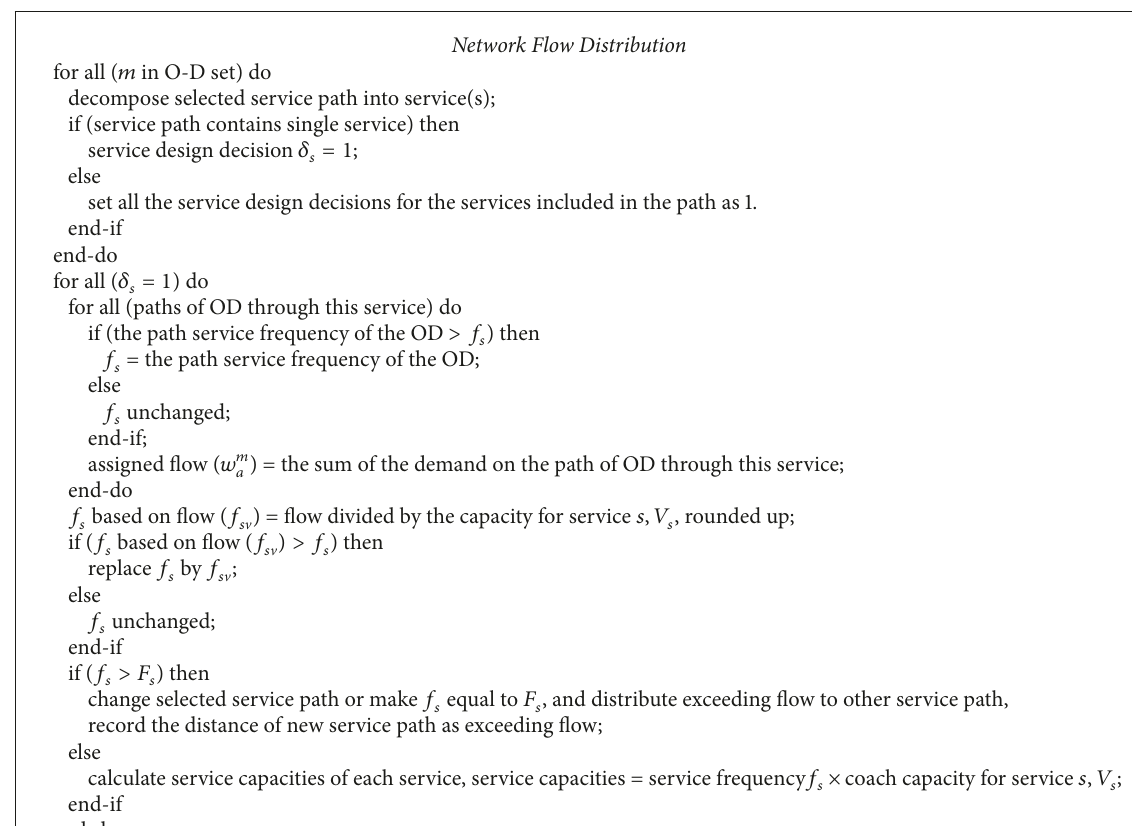
Network Flow Distribution